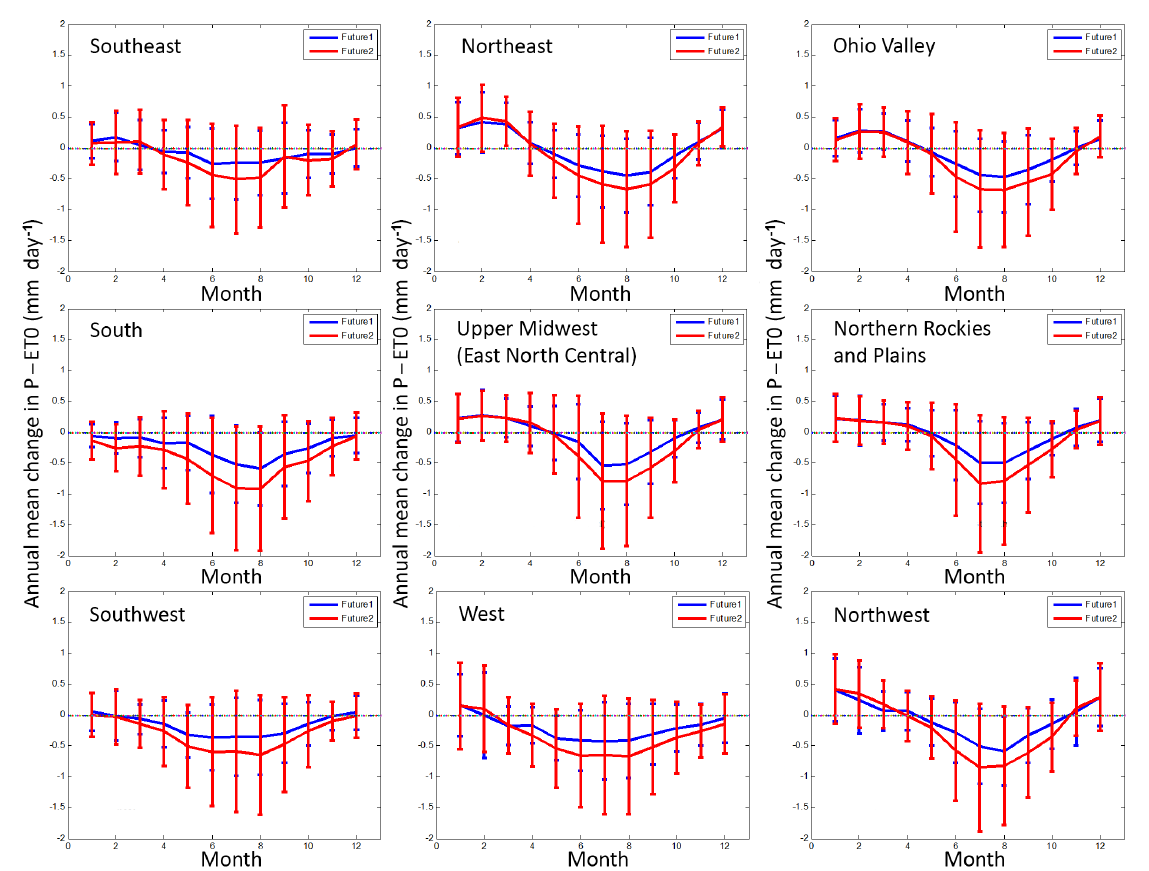
Figure 4. The change in monthly mean water deficit ( P –ET 0 ) over nine different regions. Blue lines represent future period 1 (2030–2060), and red lines represent future period 2 (2070–2100). Error bars represent 1 standard deviation of each value. The change is defined as the mean of future periods minus that of retrospective periods